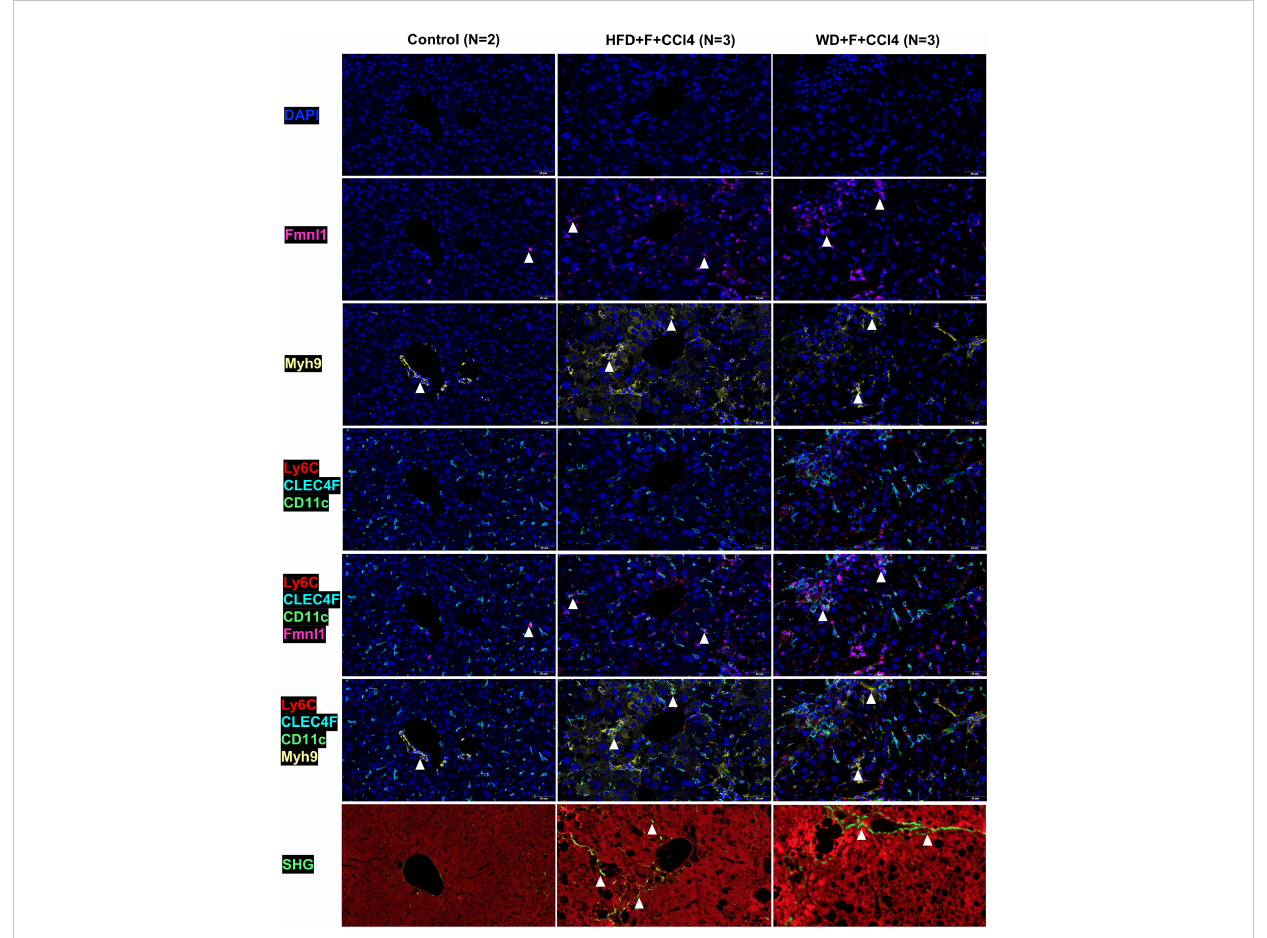
FIGURE 5 Fmnl1 and Myh9 expression in MMD system cells and collagen deposition in livers from control mice and NASH mice with fi brosis. ps: MMD: monocyte-macrophage-DC (MMD); DAPI: cell nucleus, Fmnl1: Fmnl1+ cells (white arrow), Myh9: Myh9+cells (white arrow); Ly6C/CLEC4F/CD11c/ Fmnl1: Fmnl1expression in MMD system cells (white arrow); Ly6C/CLEC4F/CD11c/Myh9: Myh9 expression in MMD system cells (white arrow); SHG, collagen detected by second harmonic